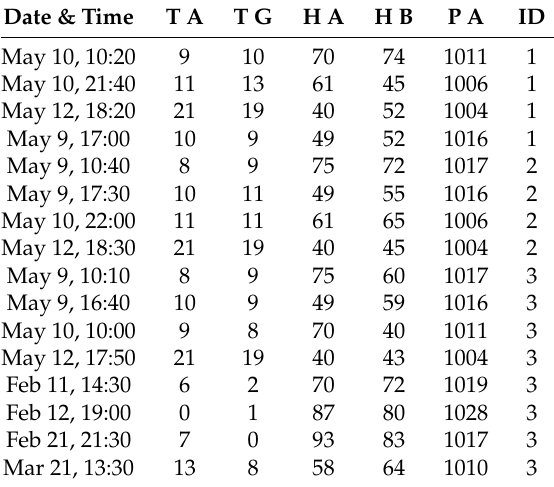
Table 2. Collected Data used for evaluation. The table shows the date of collecting the data, the time, the indicated temperature from AccuWeather (T A) and Google (T A) (unit: ◦ C), the relative humidity from the same two sources (H A) and (H G), and the ambient pressure from AccuWeather (P A) (unit: Pa). The buildings belong to the Technical University of Munich (TUM) main campus area and are (1) Agness 27, (2) Adelheid 13A, (3) Agness 33 and (4) TUM main campus. Date & Time T A T